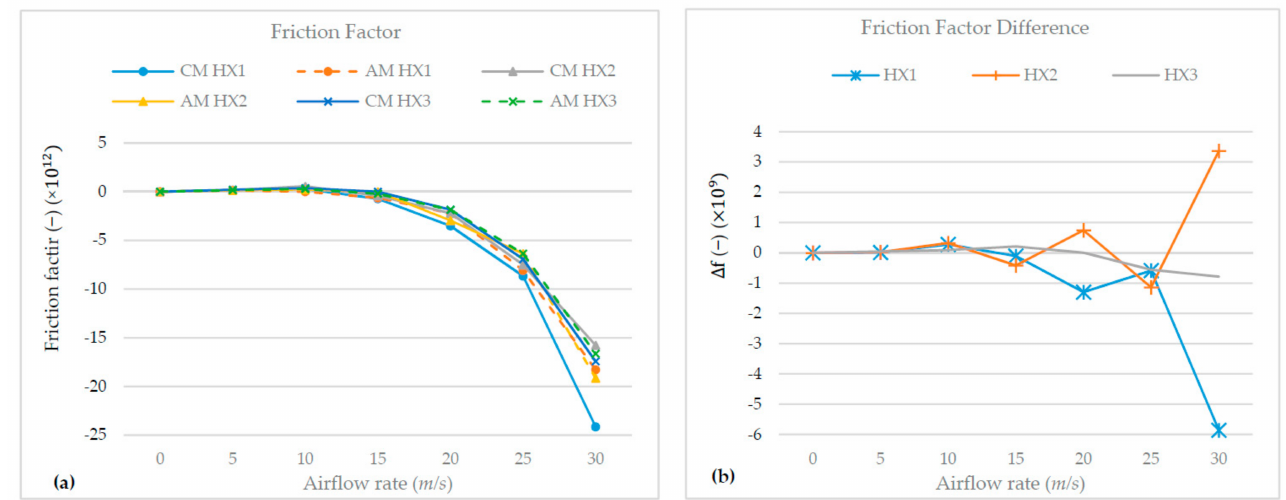
Figure 9. Experimental results when the heater temperature was 50 ◦ C: ( a ) friction factor and ( b ) friction factor difference between CM– and